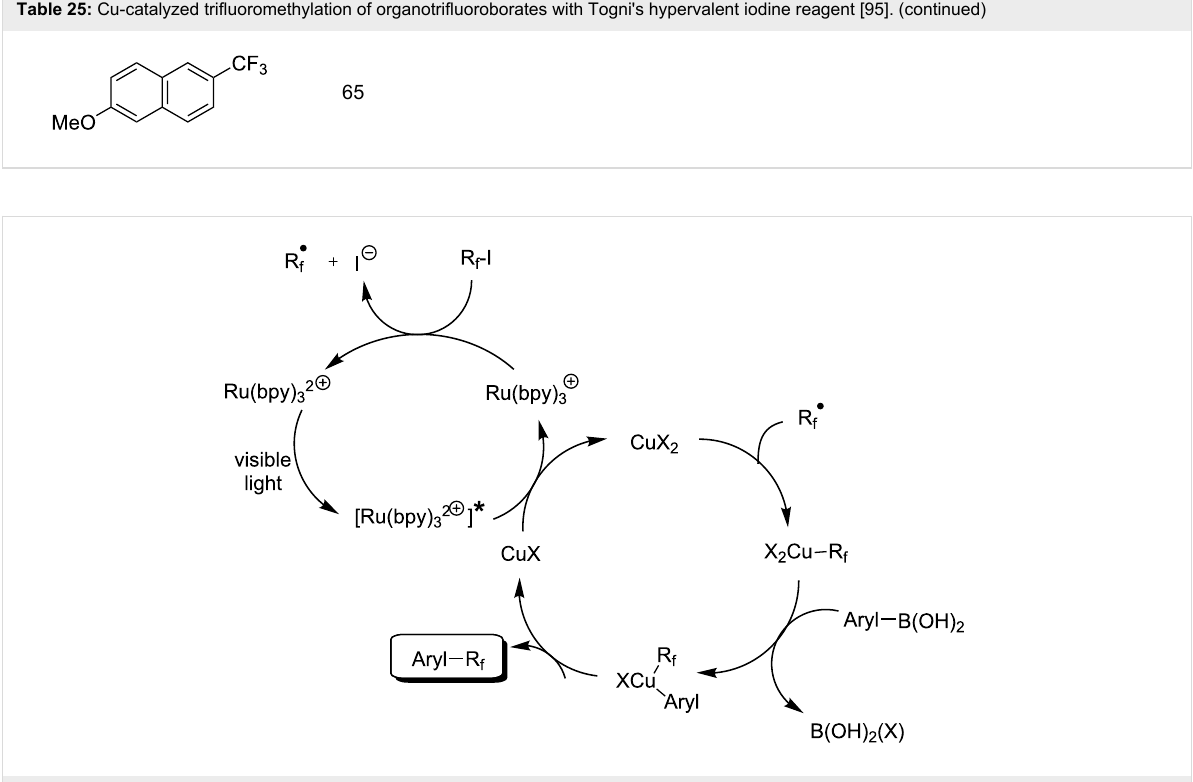
Figure 11: Mechanism of the Cu-catalyzed/Ru-photocatalyzed trifluoromethylation and perfluoroalkylation of arylboronic acids [96].